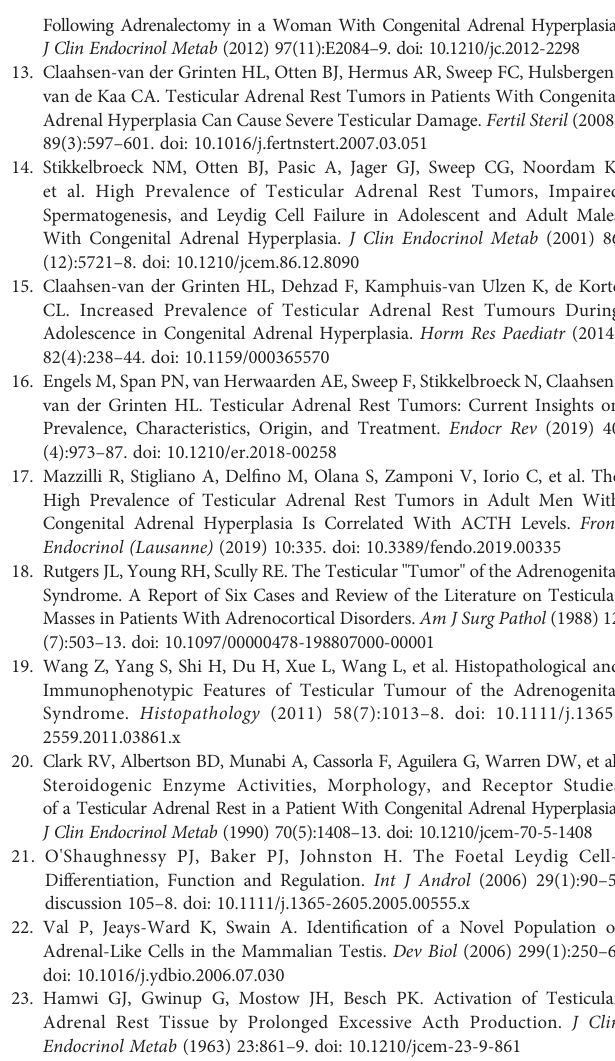
Supplementary Figure 1 | Immunolabeling of DLK1, CYB5A in control adrenal, testis and ovary. Immunohistochemical staining showing high resolution of DLK1, CYB5A staining for control adrenal, testis and ovary. In the control adrenal (original magni fi cation X40) DLK1 is positive, and strongest in the cells under the capsule and the ZG where cell proliferation is high. DLK1 is mildly stained in control testis, and negative in the control ovary (original magni fi cation X200). Low magni fi cation (original magni fi cation X40) of the control adrenal shows the entire adrenal cortex with strong positive CYB5A staining of the zona reticularis.CYB5A staining is also strongly positive in Leydig cells (arrow) in the control testis and medium to strong positive in the control ovary (Original magni fi cation